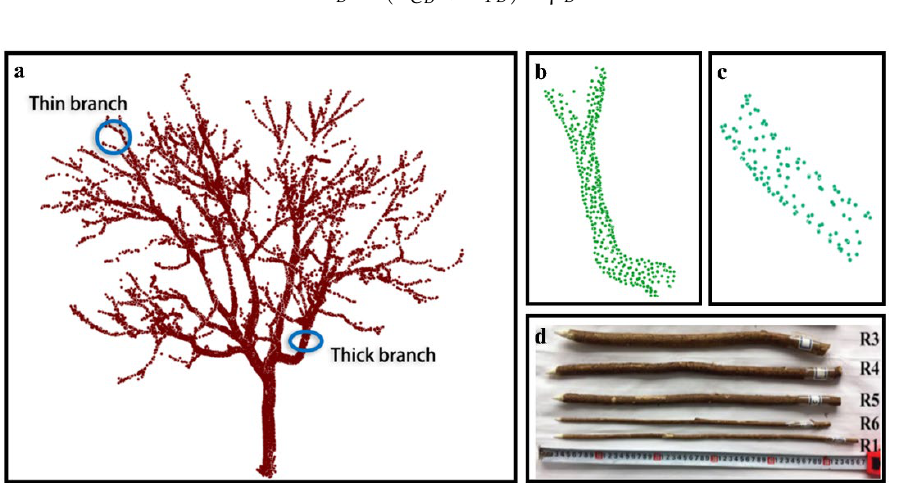
Figure 5. ( a – c ) Point cloud images of thin and thick branches, and ( d ) diagrams of measured thin branch